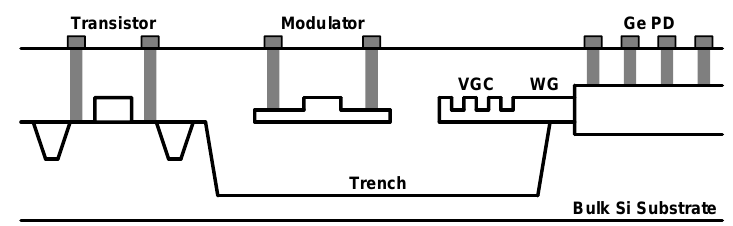
Figure 11. Schematic view of EPIC structure [51].